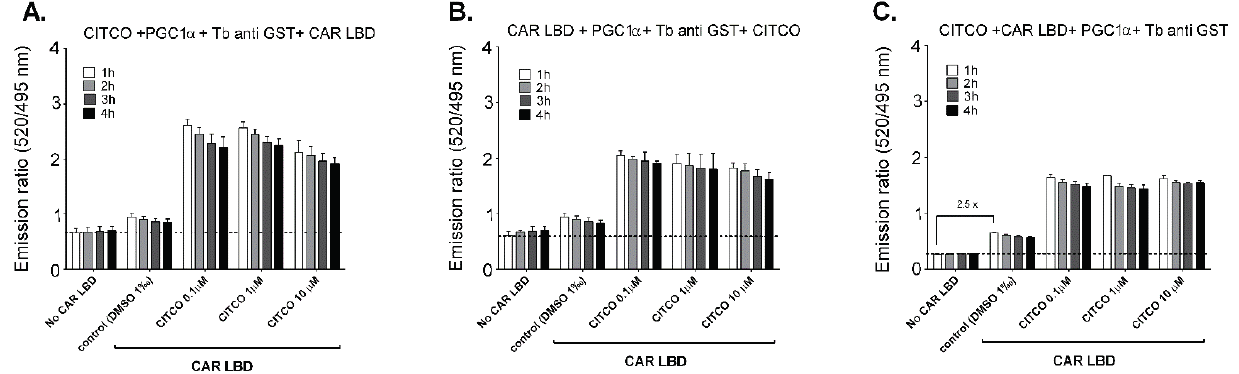
Figure 2. Optimization of the TR-FRET (Time-Resolved Fluorescence Resonance Energy Transfer) LanthaSceen TM Assay. Our TR-FRET (Time-Resolved Fluorescence